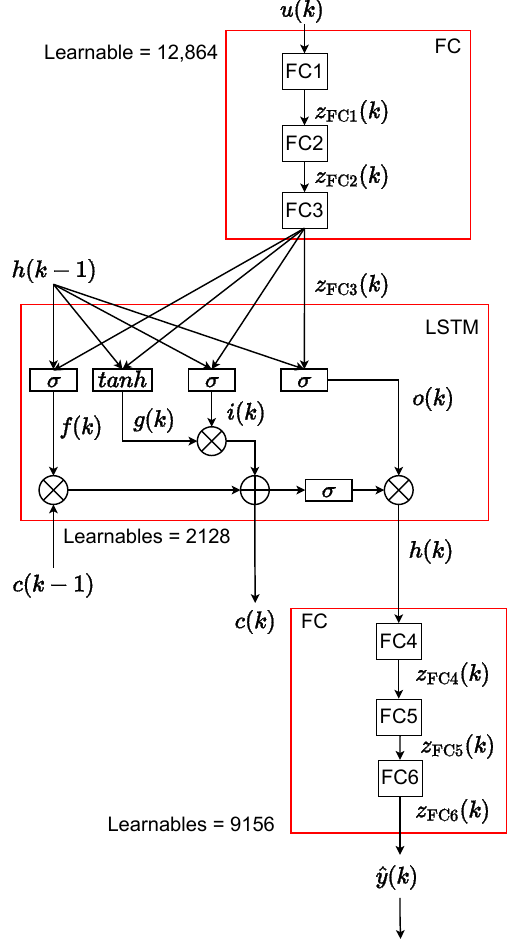
Figure 4. Computational graph of proposed deep network—FC: Fully Connected, LSTM: Long Short-Term